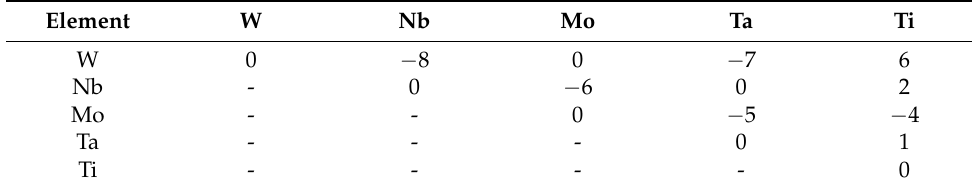
Table 2. Mixed enthalpy between elements